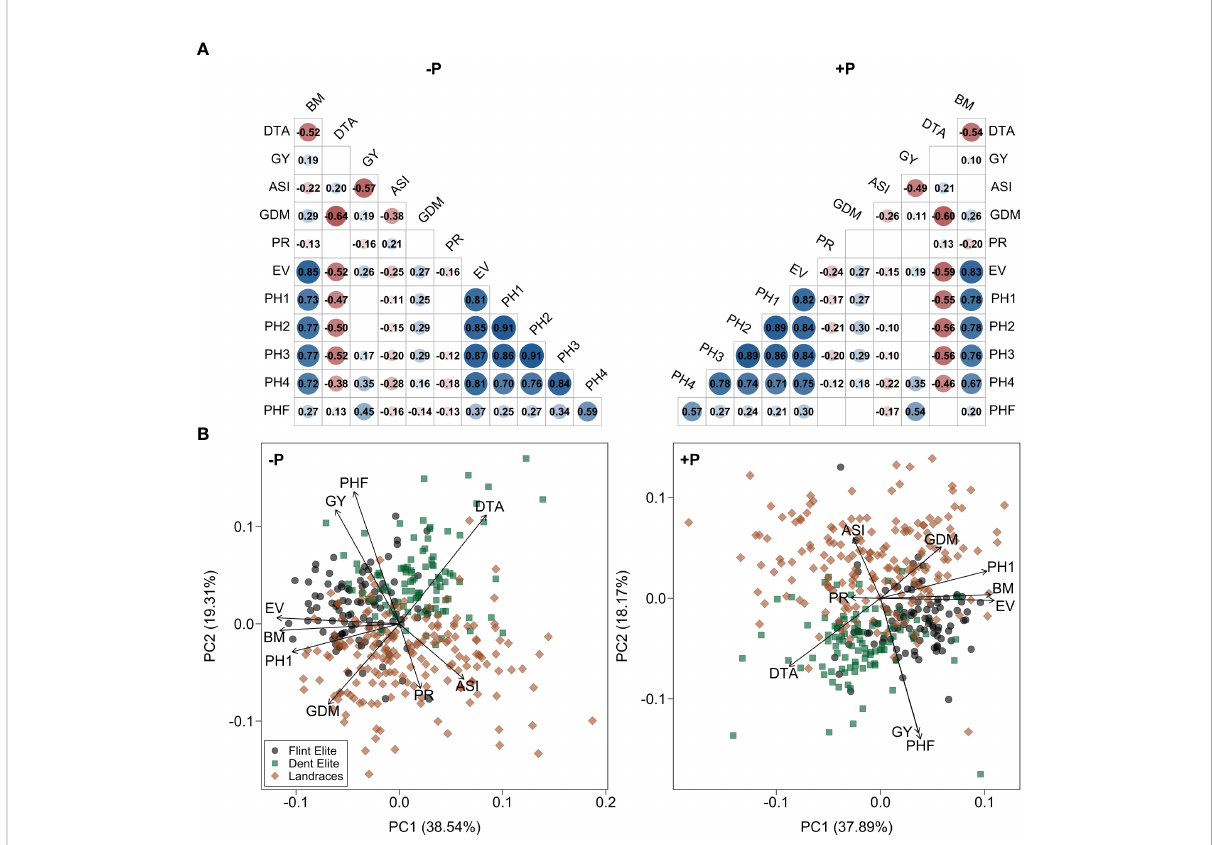
FIGURE 4 Relationships among traits in HOH20. (A) Correlation matrix and (B) principal component analysis of the lines based on phenotypic trait data. Results are shown without (-P) and with (+P) starter fertilizer. Blank fi elds in (A) are non-signi fi cant correlations. The genotypes in (B) are assigned to their material group as Dent Elite, Flint Elite and landrace doubled haploid